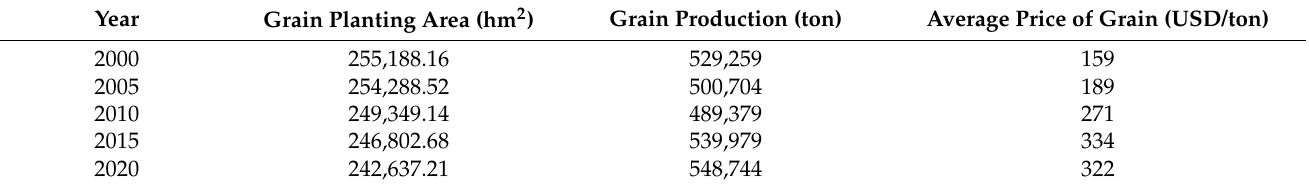
Table 2. Grain planting area, grain output, and annual average price of grain in the